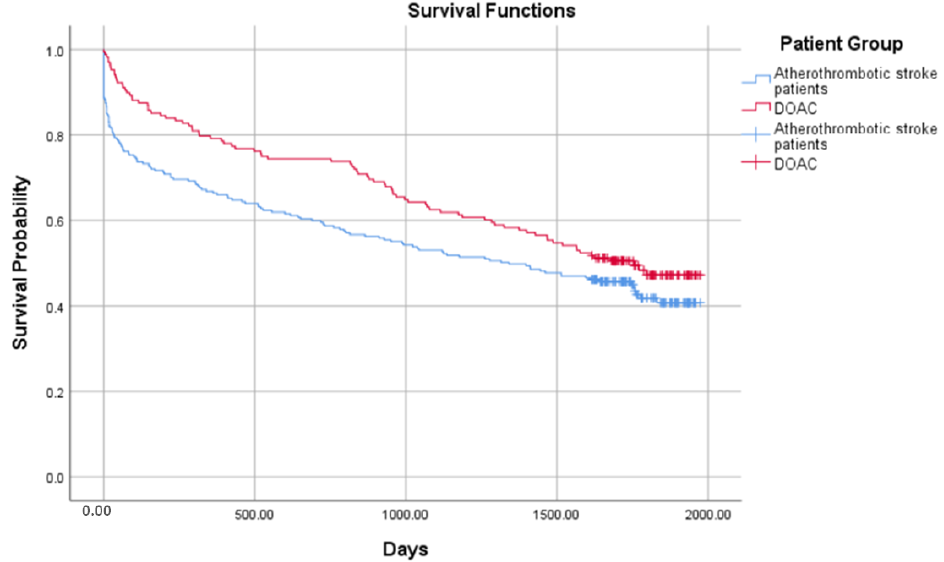
Figure 2. Probability of survival in the atherothrombotic stroke and the direct oral anticoagulant (DOAC) groups. Table 3. Cox regression measure among the patient groups.